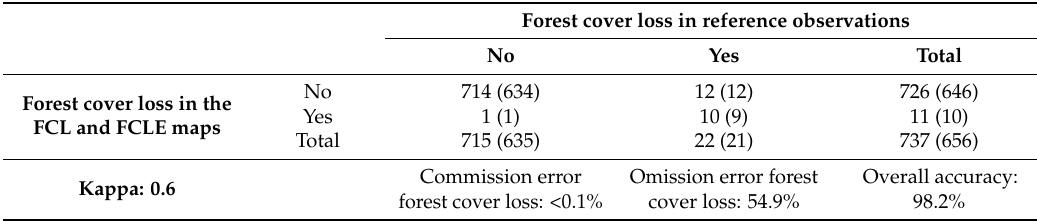
Table 2. Confusion matrix based on the reference observations. Plain values show the results of the whole data set; the data used for post-stratification are in parenthesis.